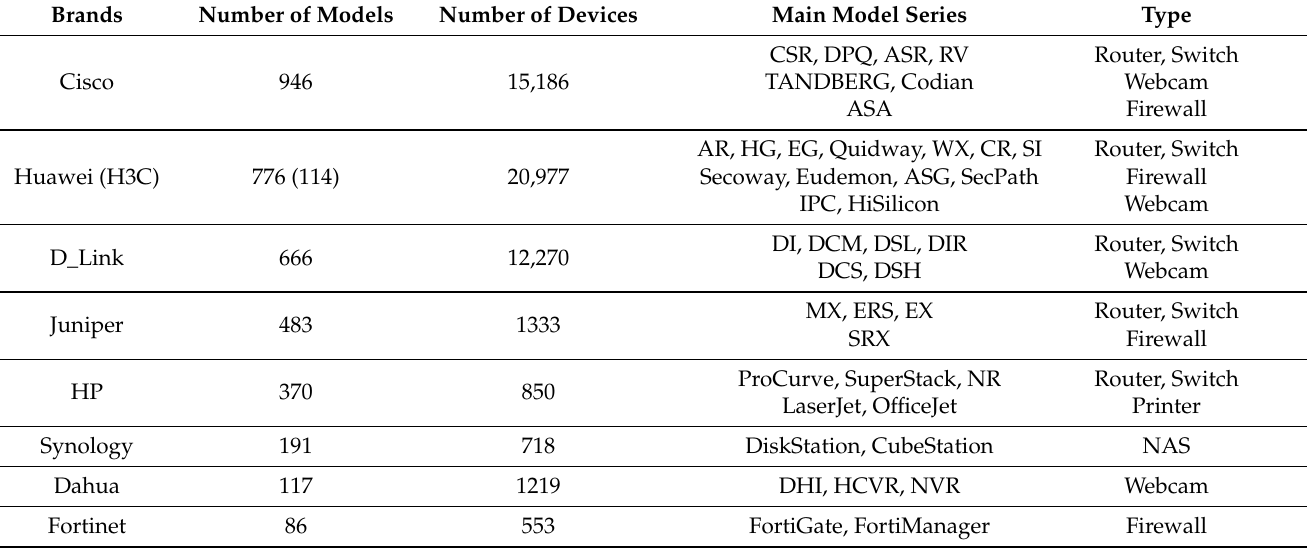
Table 2. Sample device models for the real-world